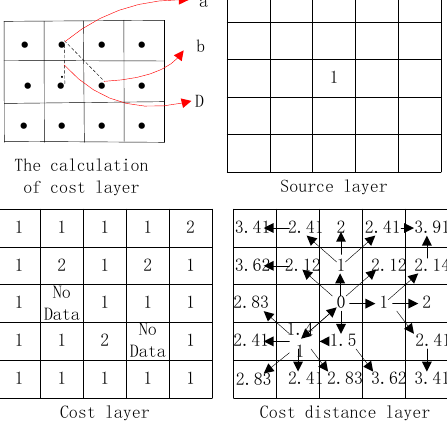
Figure 1. Least-Cost Path